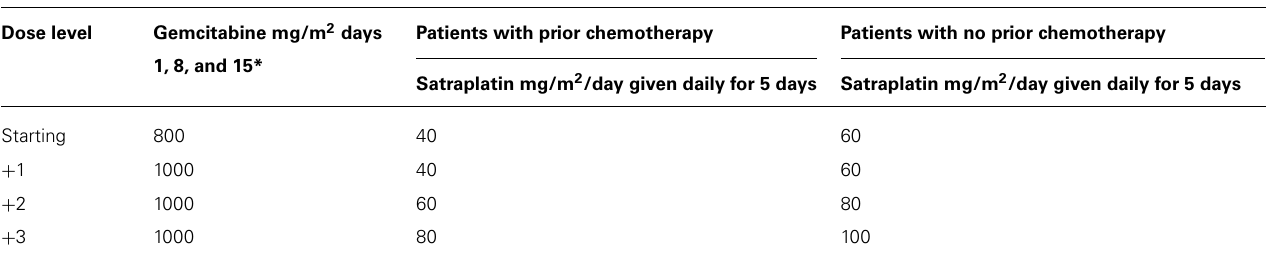
Table 1 | Dose escalation in part 1 study (every 28-day